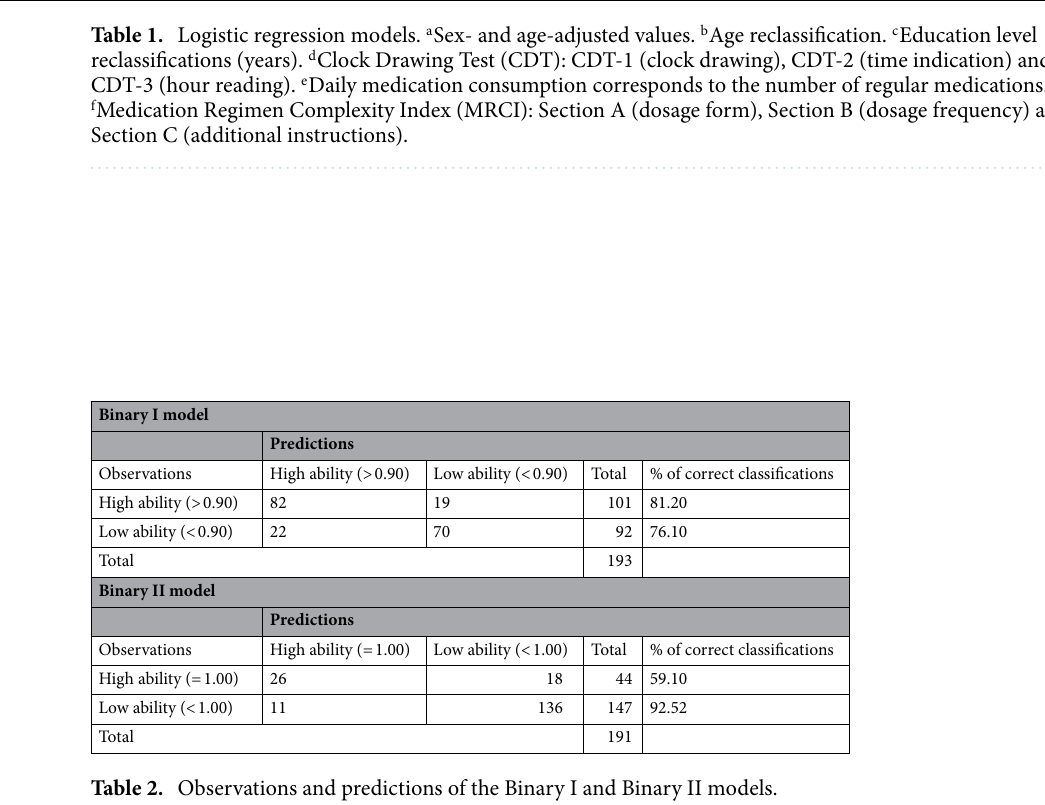
Table 2. Observations and predictions of the Binary I and Binary II